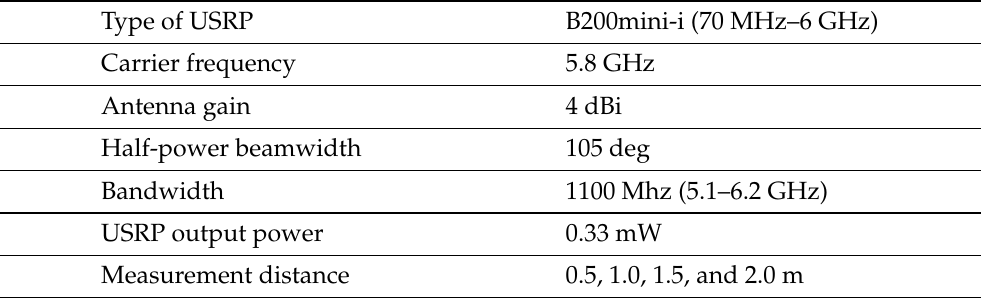
Table 2. Experiment setting and parameters.